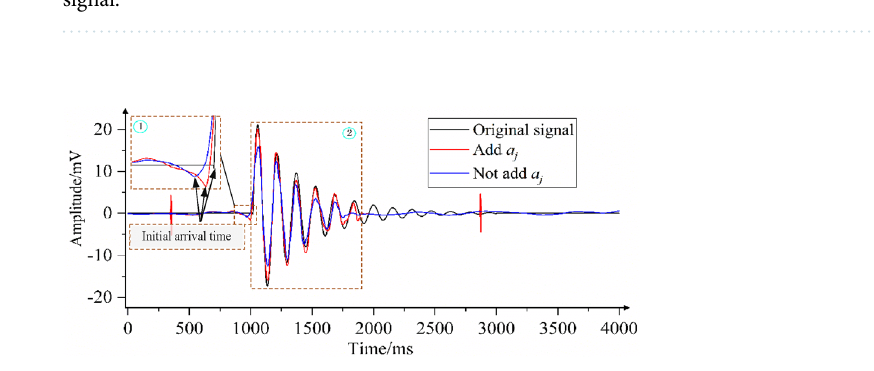
Figure 14. The comparison of the method proposed in this paper with and without adding coefficient a j to remove the noise of the microseismic simulation